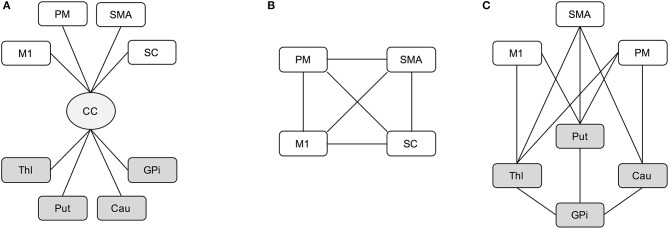
Schematic representation of transcallosal (A), cortical (B), and subcortical (C) networks. Cortical areas (white): M1, primary motor area; SMA, supplementary motor area; SC, somatosensory cortex; PM, premotor area. Subcortical nuclei (gray): Thl, thalamus; Cau, caudatus; Put, putamen; GPi, globus pallidus. Bundle of neural fibers (light gray): CC, corpus callosum.